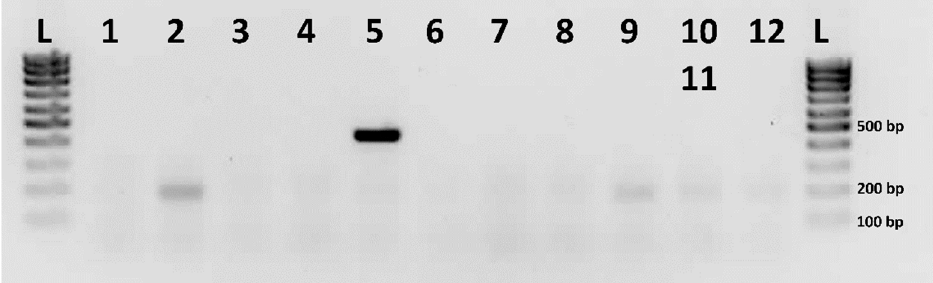
Figure 3. Agarose gel electrophoresis showing the results of PCR-assisted mapping of the male- specific RAD-seq marker M2 in C. calyptratus . Numerals refer to the chromosomes, which were iden- tified in the chromosome-specific DNA libraries prepared from C. calyptratus flow-sorted chromo- somes; L: DNA ladder.